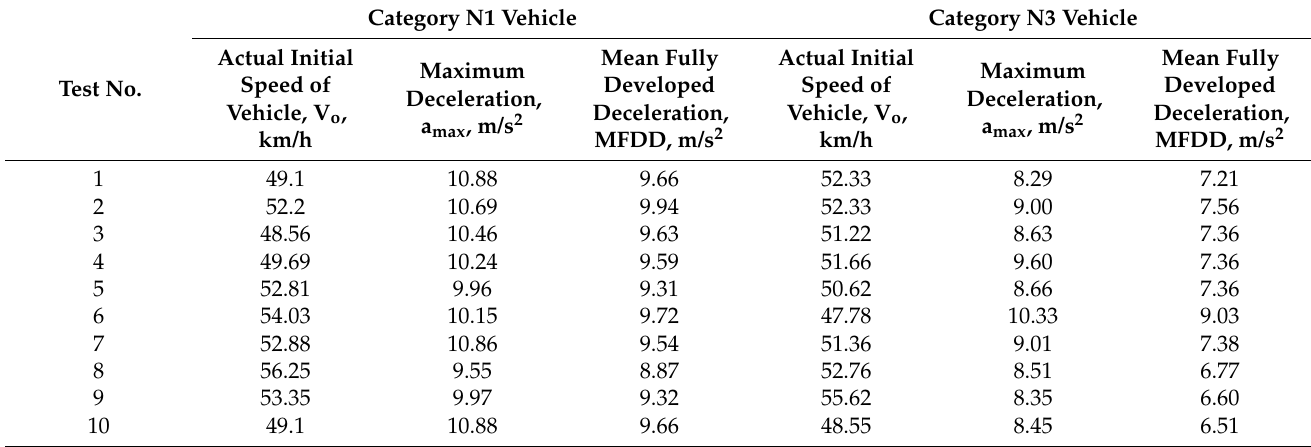
Table 2. Parameters of the progress of braking on a dry asphalt pavement from 50 km/h.